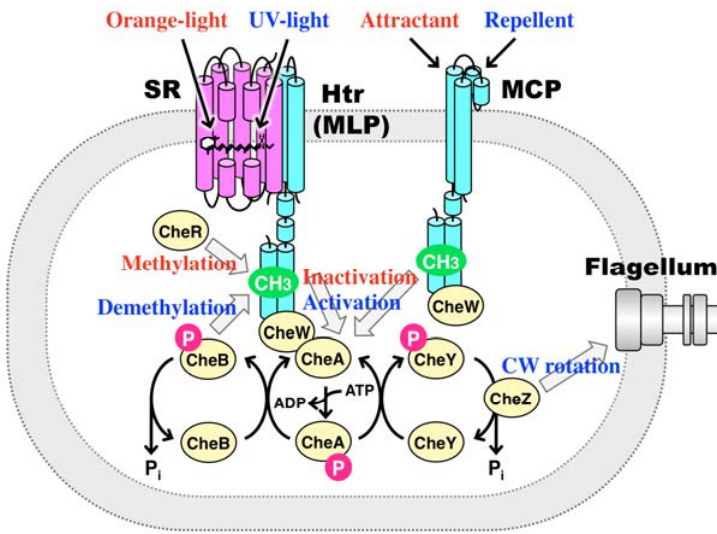
stimulation activates sensory rhodopsins (SRs) and triggers trans-cis isomerization of the retinal chromophore. Relaxation of the retinal leads to functional processes during the photocycle. SRs transmit light signals to their cognate transducer proteins (Htrs) in the membrane. Htrs form a complex with CheA and CheW, and the complex activates phosphorylation cascades that modulate the autokinase protein, CheY and controls the direction of rotation of the flagellar motor. On the other hand, the cognate chemicals (attractant and repellent) bind to the extracellular domain of the chemoreceptors (MCP) and the binding induces the structural changes of MCP. The signal transfer pathway of MCP is thought to be similar to that of the